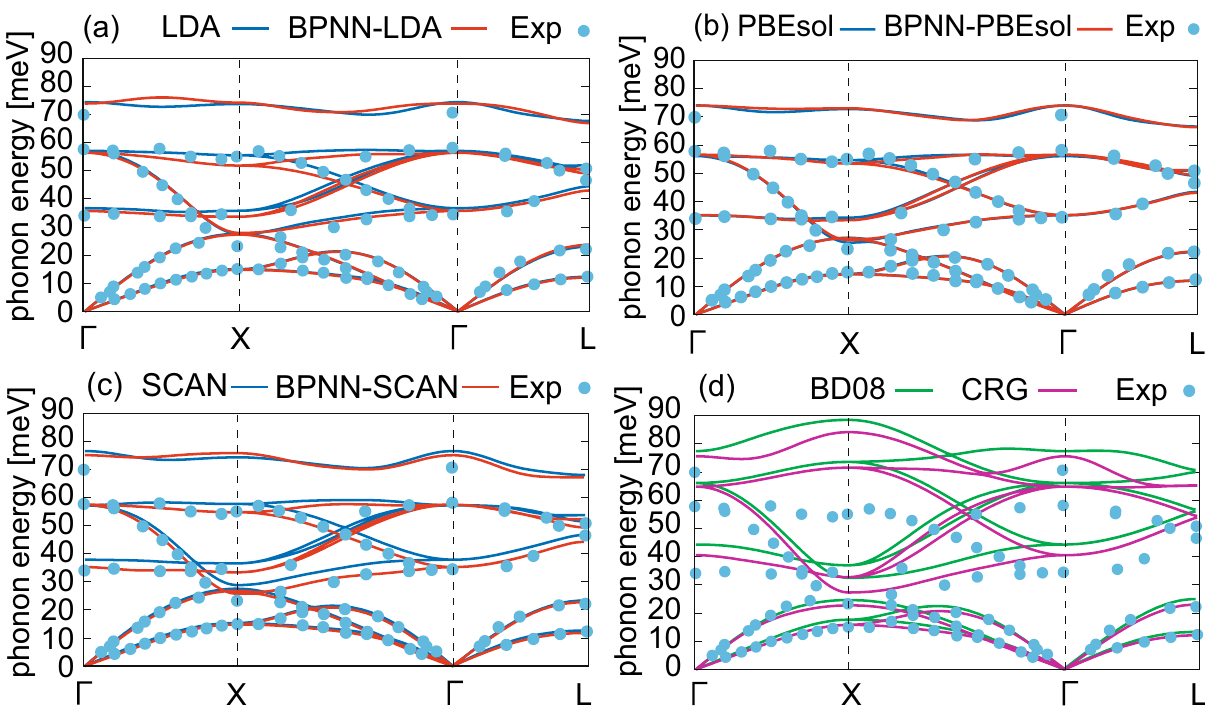
Figure 1. Phonon dispersion curves for ThO 2 . ( a–c ) Phonon dispersion obtained by (BPNN-)LDA, (BPNN-) PBEsol, and (BPNN-)SCAN where black and red line are the results computed by DFT and BPNN, respectively. ( d ) Are the results obtained by BD08 (green line) and CRG potential (purple line). Circle dots in ( a–d ) represent the experimental data.